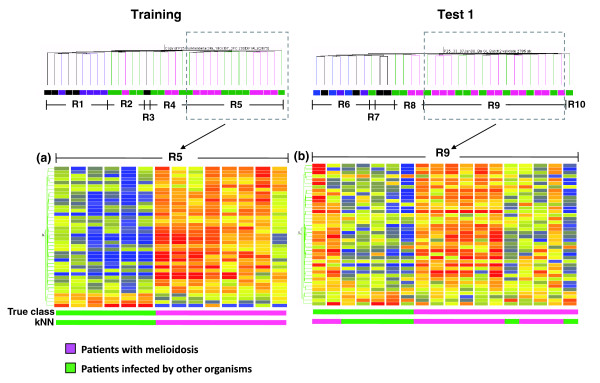
Candidate blood transcriptional markers discriminate sepsis due to B. pseudomallei from sepsis due to other organisms. (a) Patients with sepsis in R5 of the training set (comprising eight patients with melioidosis (pink rectangles) and six patients with sepsis caused by other organisms (green rectangles)) were subjected to class prediction analysis (K-nearest neighbors (kNN)) using the leave-one-out cross-validation scheme. This algorithm identified 37 classifiers that discriminated samples with 100% accuracy in the training set. (b) Independent validation of the 37 predictors was performed with the equivalent region R9 in test set 1, including 11 patients with melioidosis (pink) and 7 patients with sepsis caused by other organisms (green). The predictors correctly classified 14 of the 18 samples (78% accuracy).